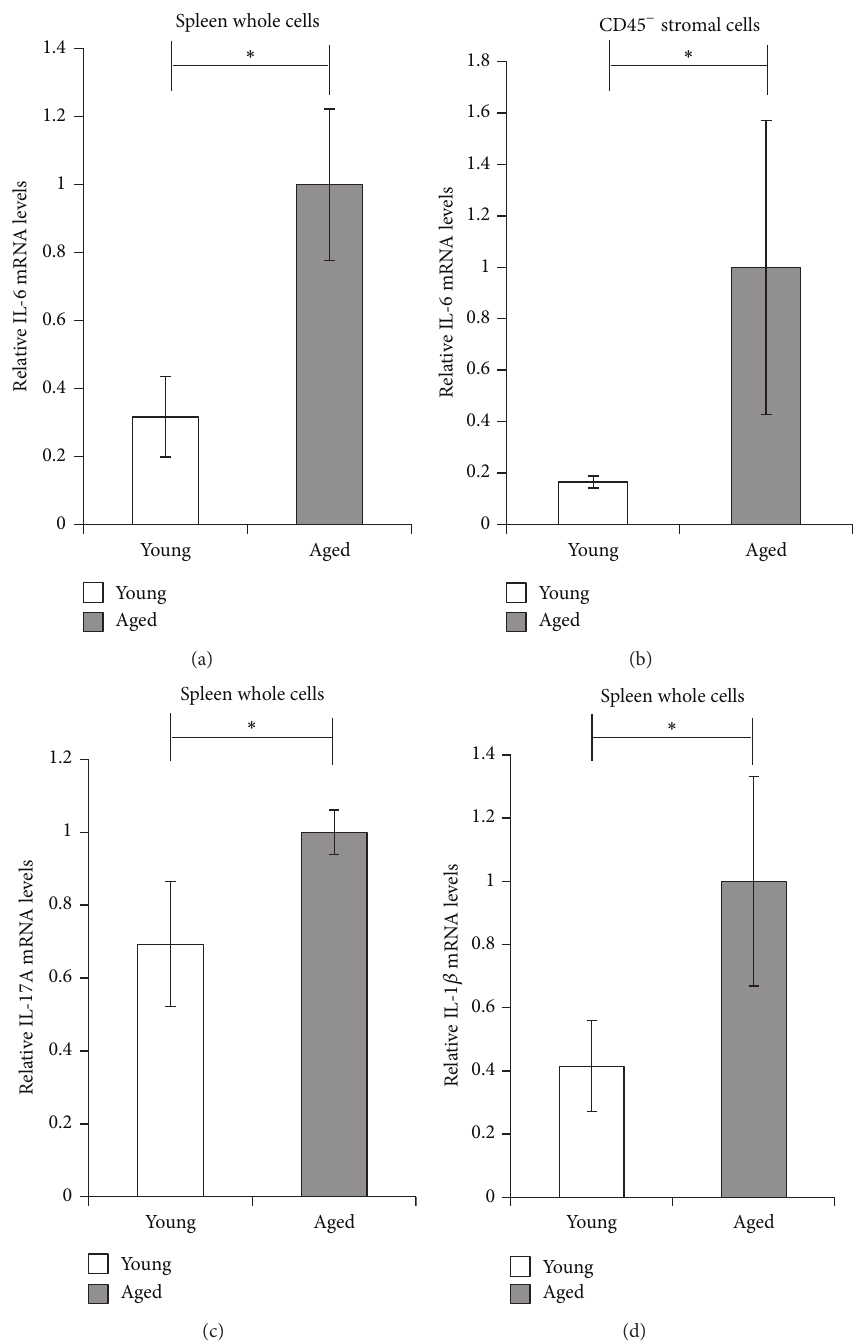
Figure 5: IL-6 and IL-17 mRNA expression levels in whole spleen cells and CD45 − stromal cells in vivo after LPS intraperitoneal administration for 1.5h. (a) IL-6 mRNA of freshly isolated whole spleen cells from young and aged mice ( 𝑛 = 3 ) was measured by quantitative RT-PCR after LPS injection (3.3 𝜇 g/g body weight). The average normalized IL-6 mRNA level in aged mice was set at 1.0. (b) IL-6 mRNA of splenic CD45 − stromal cells from young and aged mice ( 𝑛 = 5 ) sacrificed 1.5h after injection was measured by quantitative RT-PCR. The average normalized IL-6 mRNA level in aged mice was set at 1.0. ∗ P < 0.05. (c) IL-17 mRNA and (d) IL-1 𝛽 of freshly isolated whole spleen cells from young and aged mice ( 𝑛 = 3 ) were measured by quantitative RT-PCR after LPS injection. The average normalized IL-17 mRNA level in aged mice was set at 1.0. The results are expressed as mean ±